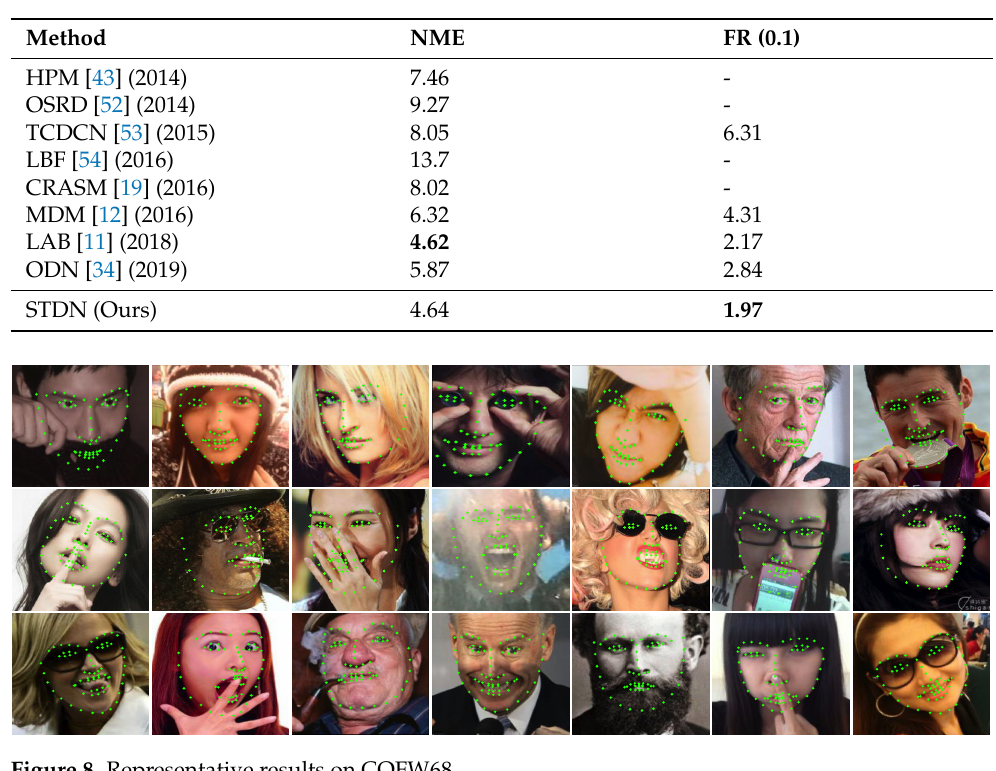
Table 4. NME (in %) of 68-point landmark detection on COFW68.